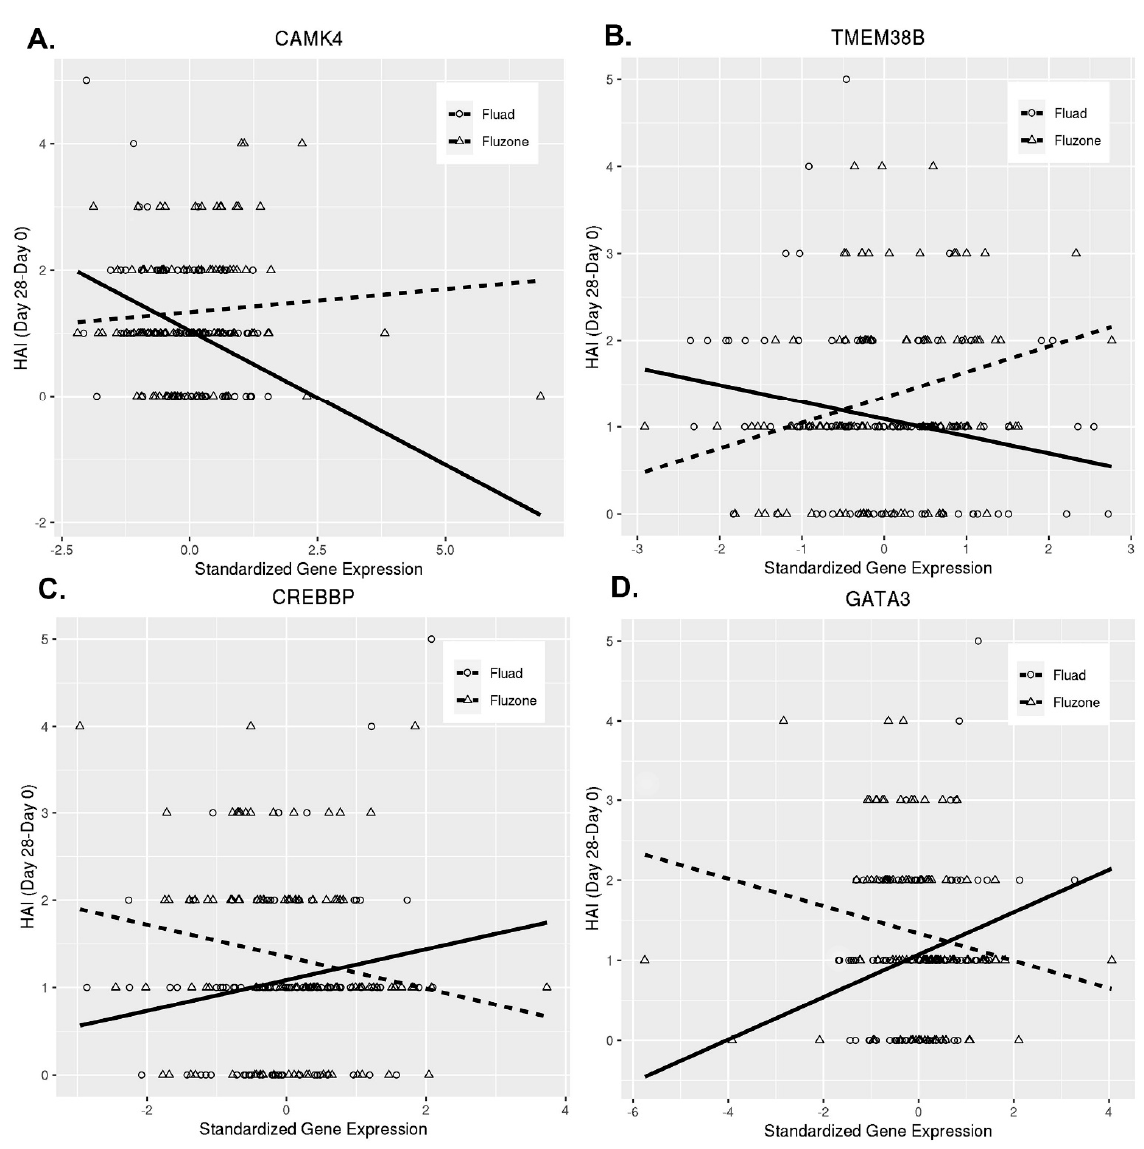
Figure 2. Differential effect of selected significant genes on immune outcome in the two vaccine groups. Interaction plots for CAMK4 ( A ), TMEM38B ( B ), CREBBP ( C ), and GATA3 gene ( D ) demonstrate the differential effect on the immune outcome by vaccine type (i.e., the different trajectories of association for the Fluad (solid line, circles) versus Fluzone (dashed line, triangles) vaccines for the specific genes. The horizontal axis represents the standardized gene expression Day 28/Day 0 change (gene expression minus the mean divided by the standard deviation); a one unit change in the standard gene expression is equivalent to a one standard deviation change in gene expression. The vertical axis is the log 2 change in HAI titer from Day 0 to Day 28; a one unit increase in the log2 HAI measure represents a doubling of the HAI titer from Day 0 to Day 28.